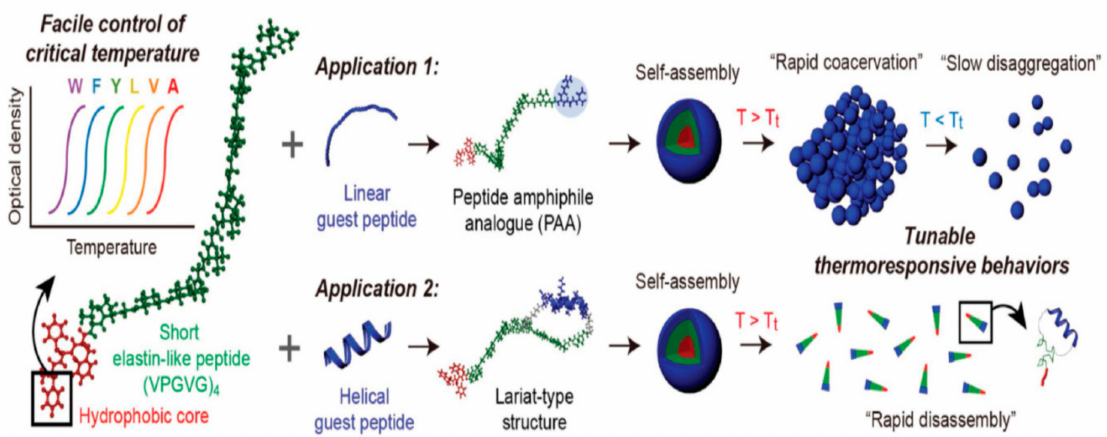
Figure 1. Peptide platform based on an miniaturized elastin-like peptide (MELP) for developing elastin-like peptide (ELP) amphiphiles with a thermo-responsive behavior that can be controlled by varying the types of conjugated guest–peptides, macromolecular topologies, and N-terminal amino acid residues. Reprinted with permission from